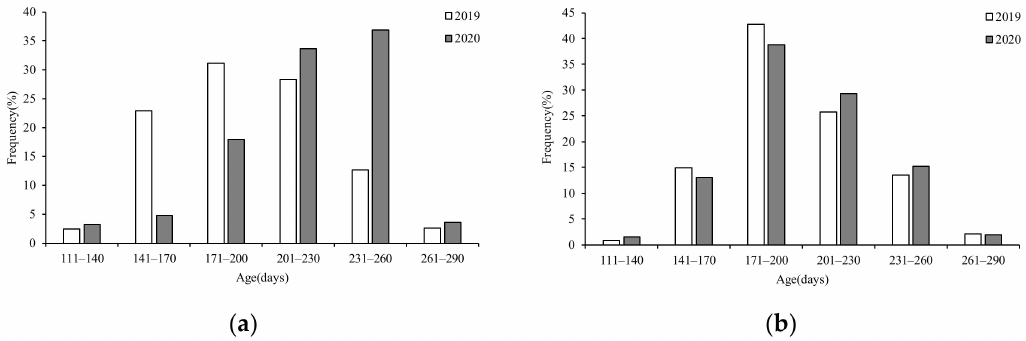
Figure 6. Composition of age for S. oualaniensis in different years: ( a ) female ( b ) male. Maturity status differed between sexes were observed in two years of S. oualaniensis samples (Figure 7). In 2019, the majority of females (87.46%) were in stages I and II, while the majority of males (90.72%) were in stages II–IV (Figure 7a,b). In 2020, the majority (77.25%) of female samples were in stages III and IV (Figure 6a), and the majority (71.93%) of male samples were in stages III and IV (Figure 7a,b).